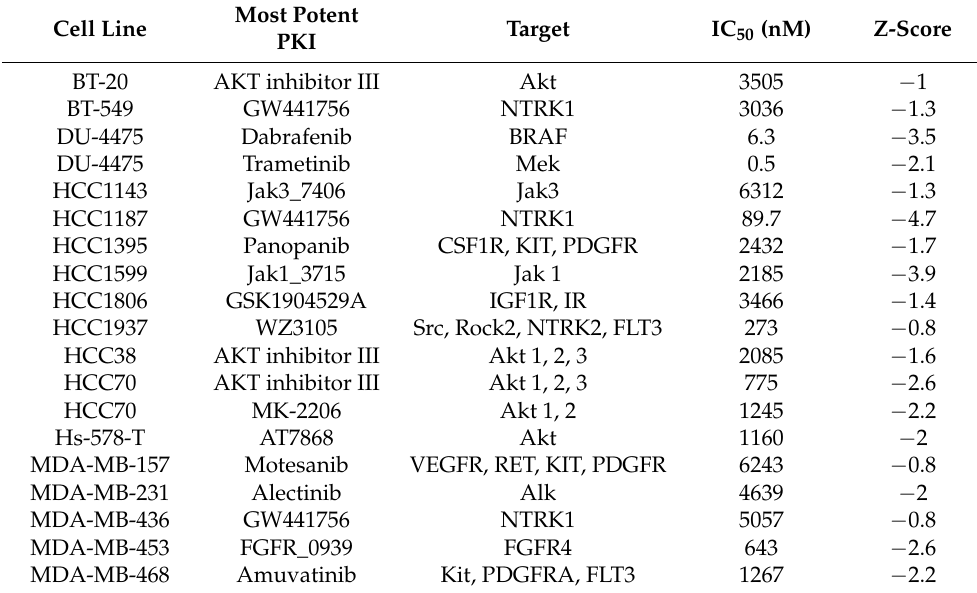
Table 1. TNBC cell lines and their most potent signaling protein kinase inhibitors in the Genomics of Drug Sensitivity in Cancer (GDSC1)